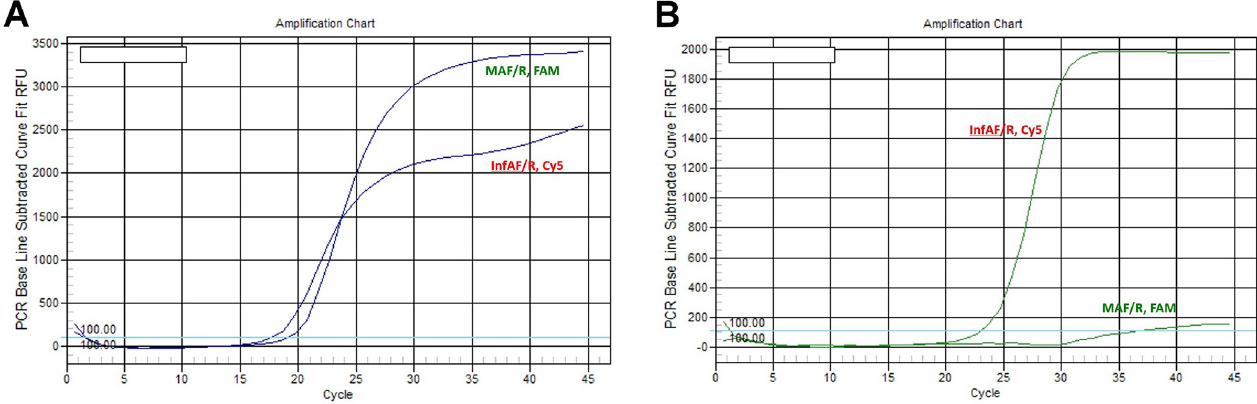
Fig 2. Representative real-time multiplex RT-PCR curves for the detection and differentiation of Influenza A pdm H1N1 and H3N2 viruses. A. Data showing InfAF/R (+) and MAF/R (+) for the diagnosis of Influenza A pdm H1N1 virus. B. Data showing InfAF/R (+) and MAF/R (-) for the diagnosis of Influenza A H3N2 virus. The horizontal blue lines represent the threshold cycle (C T ) values. MA and InfA, two types of primers; F/R, forward/reverse; FAM and Cy5, different Taqman probes for the assays.